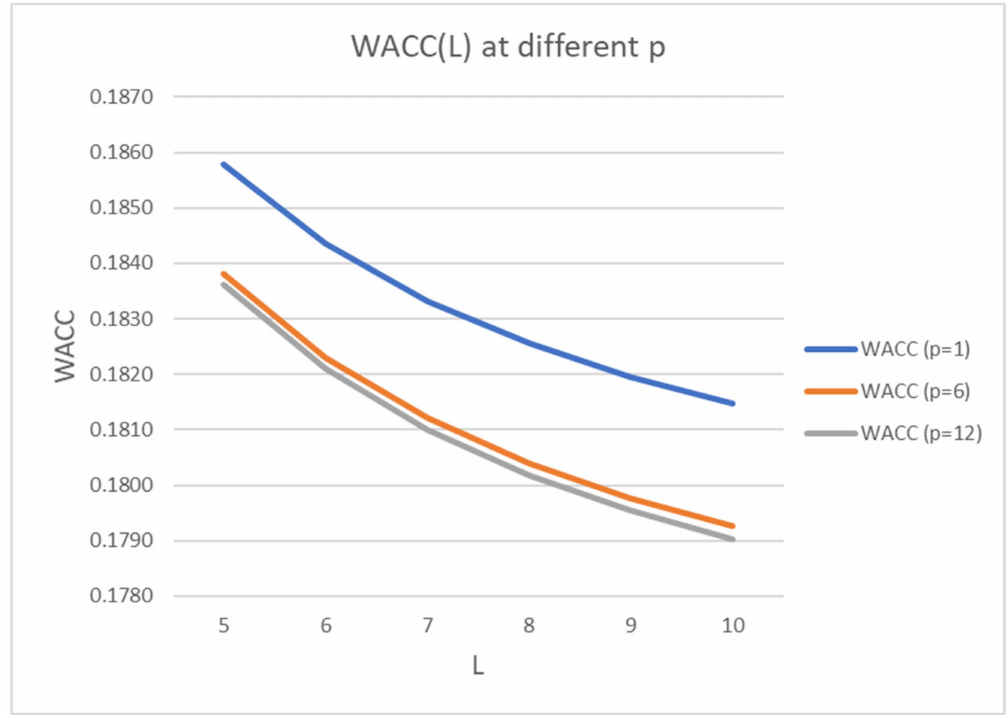
Figure 3. Dependence of WACC on leverage level L at k 0 = 0.22, k d = 0.14 and different p = 1, 6, 12 for a three-year project (larger